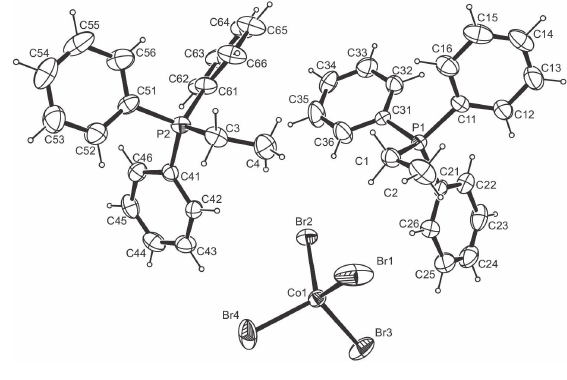
Table 2: Atomic coordinates and displacement parameters (in Å 2